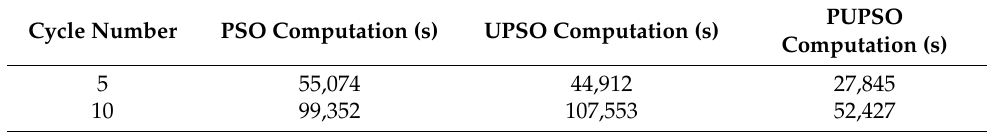
Table 11. Comparison of computational time with two computing